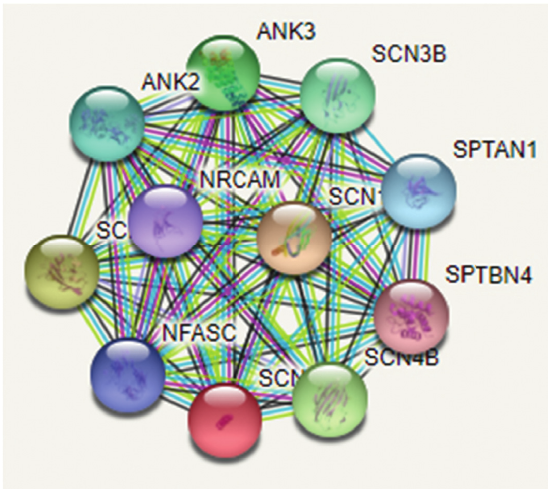
Figure 3: Protein interaction network of